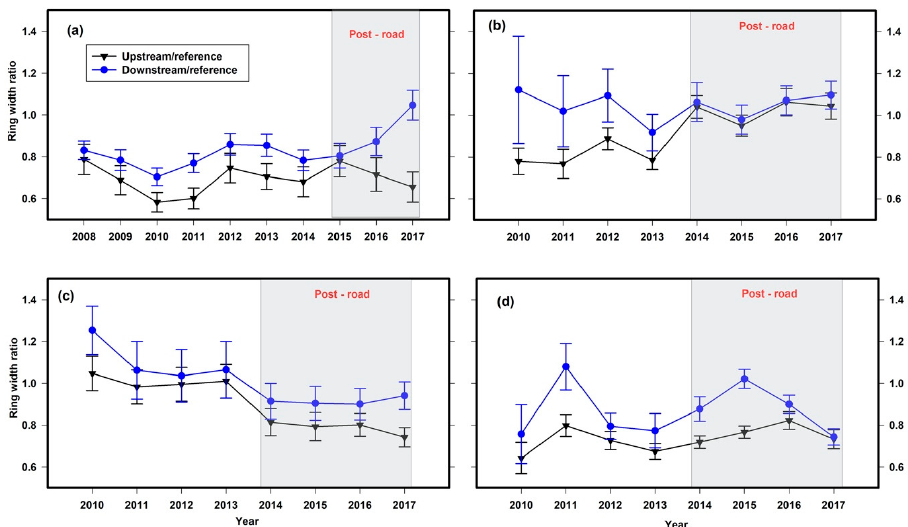
Figure 2. Annual growth ring width ratios of ( a ) black spruce, ( b ) alder, ( c ) birch and ( d ) willow from 2008 to 2017 in the bog and 2010 to 2017 in the fen sites of Carmon Creek, Peace River, Alberta. Years 2015–2017 in the bog and Years 2014–2017 in the fen represent the period post-road construction. Symbols and error bars represent the mean and standard errors of annual growth ring width ratios for the respective year. Upstream / reference-ratio of upstream and reference site ring widths and downstream / reference-ratio of downstream and reference site ring widths. Table 3. Generalized linear mixed e ff ect models, years (2016 and 2017) and plots as random factors, results showing the e ff ects of basal diameter (BD) and depth to water table with respect to surface (WT) on annual tree ring growth 1 of black spruce in the bog, and alder, birch and willow in the fen, Carmon Creek, Peace River, Alberta,